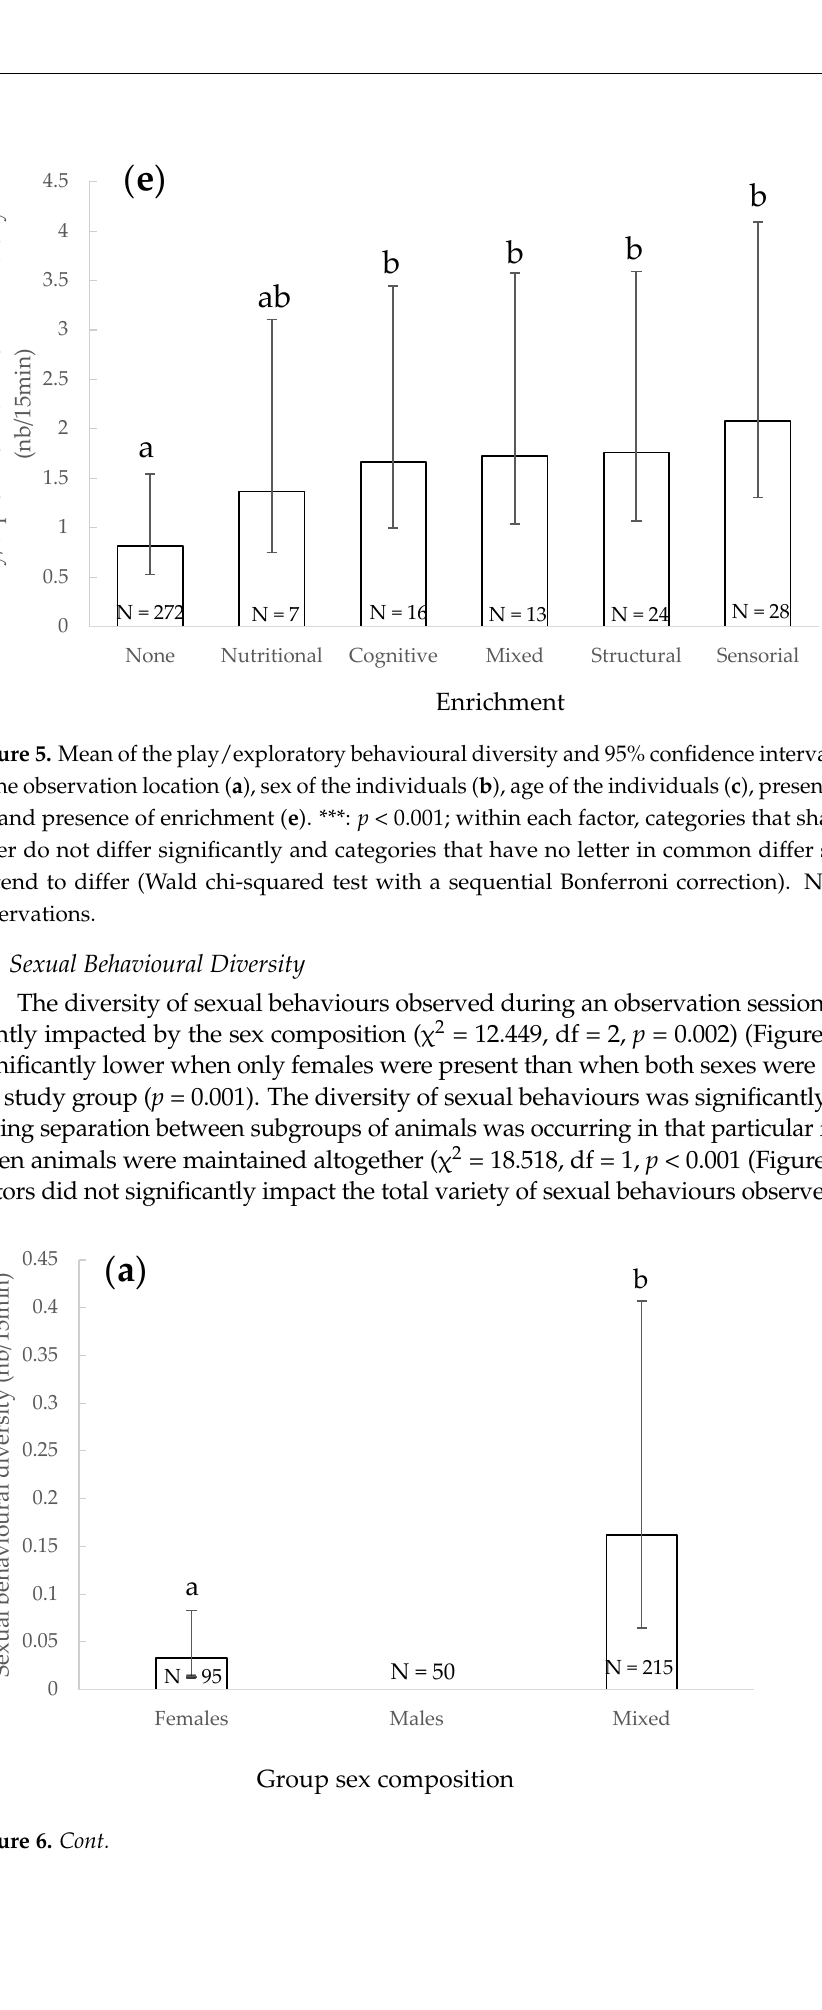
Figure 6. Mean of the sexual behavioural diversity and 95% confidence intervals according to the sex composition ( a ) and social grouping ( b ). ***: p < 0.001; within each factor, categories that share the same letter do not differ significantly and categories that have no letter in common differ significantly (Wald chi-squared test with a sequential Bonferroni correction). N: number of observations. 3.7. Maternal Behavioural Diversity The diversity of maternal behaviours observed during an observation session significantly increased with the number of individuals present (χ 2 = 13.091, df = 1, p < 0.001) (Figure 7a) and with the number of mother–calf pairs present (χ 2 = 57.840, df = 1, p